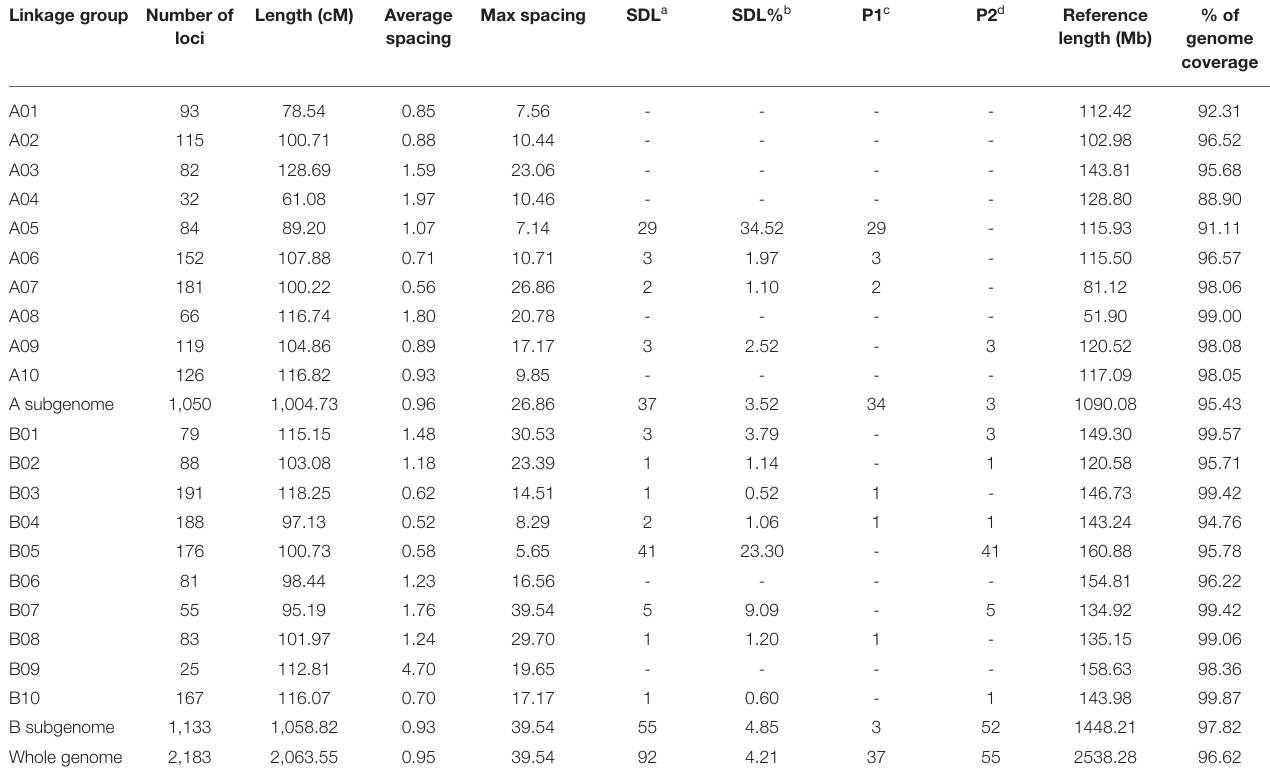
TABLE 2 | Description of the high-density genetic linkage map constructed in the present study. Linkage group Number of